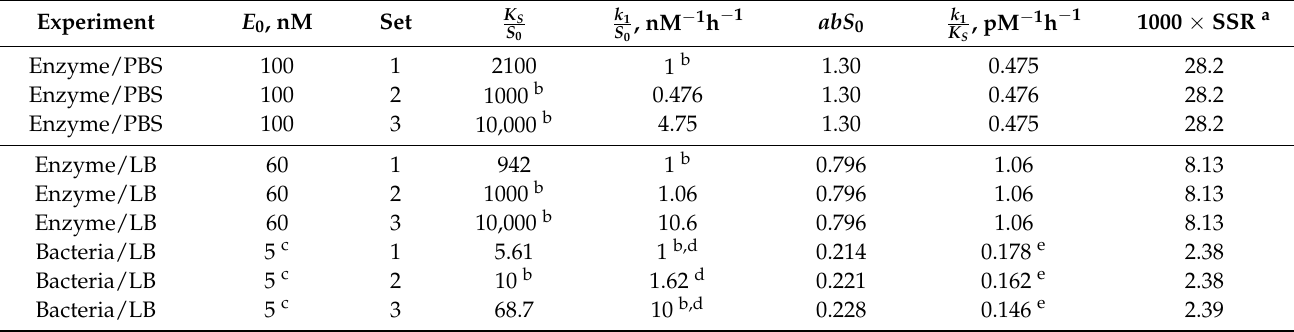
tically straightforward correlation of K S and k 1 into account, see Table 1, the latter is (cid:3038) (cid:3117) S 0 S 0 (cid:1831) (cid:3040)(cid:3028)(cid:3051) in h − 1 . (cid:3012) (cid:3268) assumed to be equal to 1 nM − 1 h − 1 . While the thermodynamic equilibrium constant (cid:1837) (cid:3020) appears in the left side of (5), the Table 1. Correlation of parameters K S and k 1 in Equation (5) for the enzymatic reaction of chitosan-g-X-Gluc with ß-Gus in kinetic rate constant (cid:1863) (cid:2869) and analytical enzyme concentration (cid:1831) (cid:2868) are present only on the PBS at pH 7.4 (25 ◦ C) and in LB at pH 7.0 (25 ◦ C) as well as in E. coli Mach1 bacterial suspension in LB at pH 7.0 (20 ◦ C). (cid:3038) (cid:3117) (cid:1831) (cid:1872) form a right side as a product. In this case the roots (cid:1876) (cid:3032) of (5) vs. unitless time (cid:2868) (cid:3020) (cid:3116) universal global line for all enzymatic kinetics in a series with different (cid:1831) (cid:2868) or (cid:1856) . The results of such a global fit for enzymatic reactions in PBS, LB and bacterial suspension shown in Figure 7 and Table 2 allow one to conclude that the enzymatic reaction of chi- tosan-g-X-Gluc in a complete set of analytical enzyme concentrations can be quantita- tively described by the Michaelis–Menten reaction scheme (1) with only two generalized